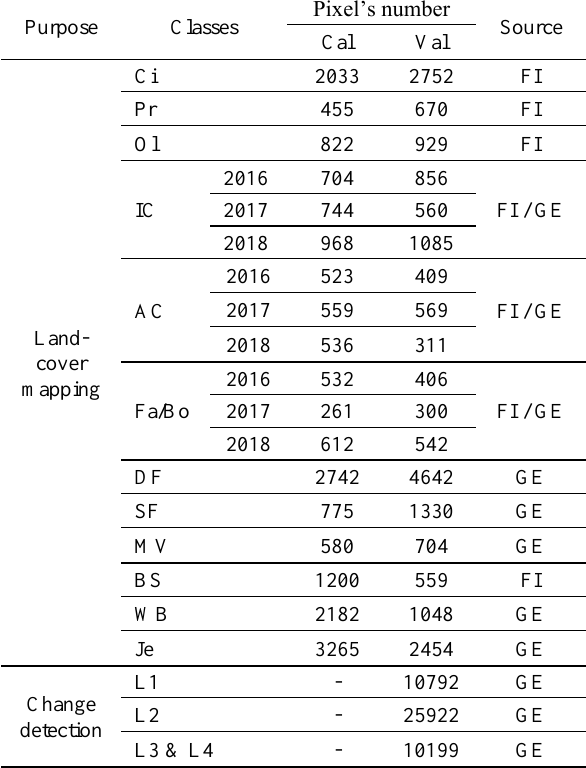
Table 1. Description of satellite data used in this study, including sensor types, resolutions and temporal distribution of acquisition dates.